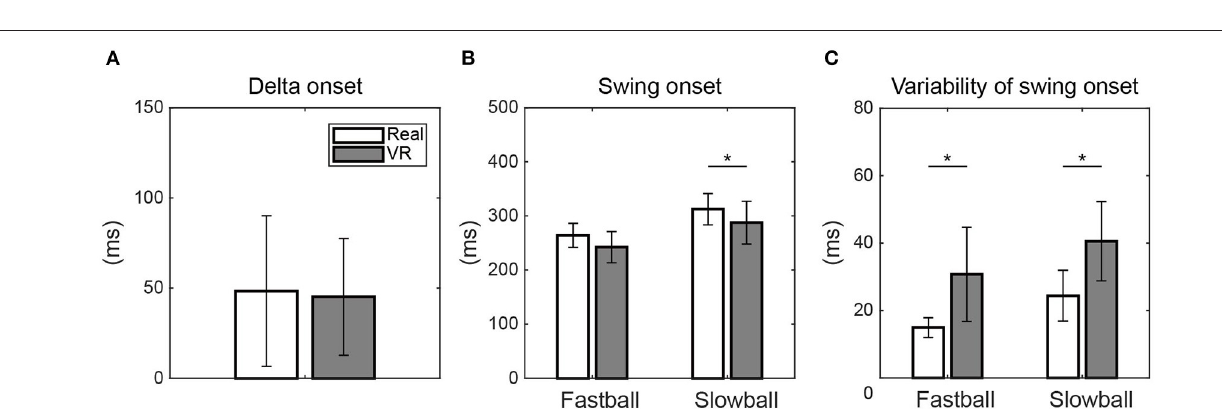
FIGURE 2 | Relationships of the delta onset and swing onsets between real and VR environments. The delta onset (A) and the swing onset for the slowball (C) showed a high correlation between environments, while the swing onset for the fastball (B) showed a low correlation.